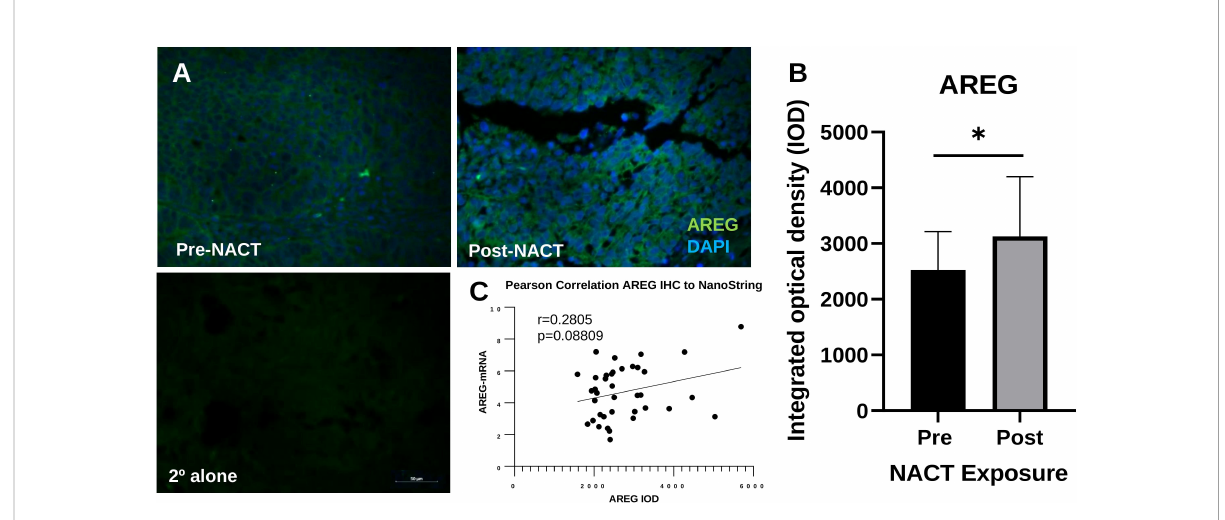
FIGURE 5 Intratumoral AREG is increased post-NACT. (A) Representative IHC images of AREG protein pre-NACT and post-NACT. AREG = green; DAPI (nuclear) = blue. 2° alone = secondary antibody control. (B) Quanti fi cation of AREG integrated optical density pre-NACT and